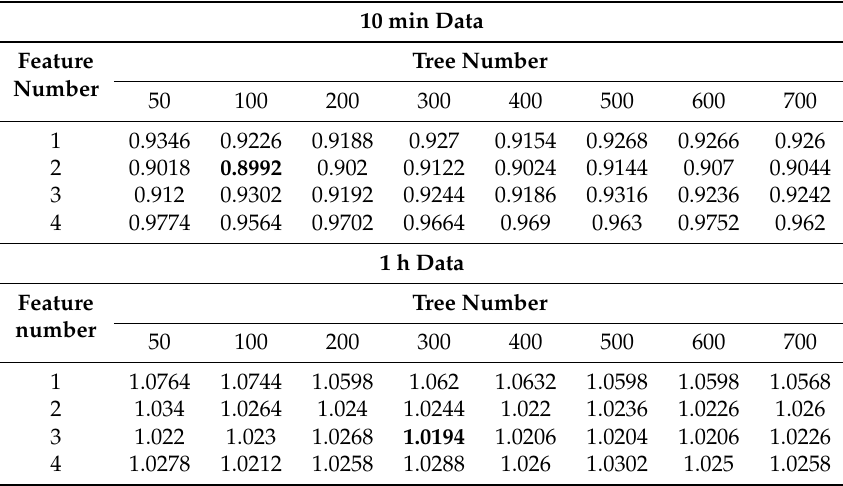
Table 6. Single RF model selection for wind speed time series at the HLJ site (MAE).